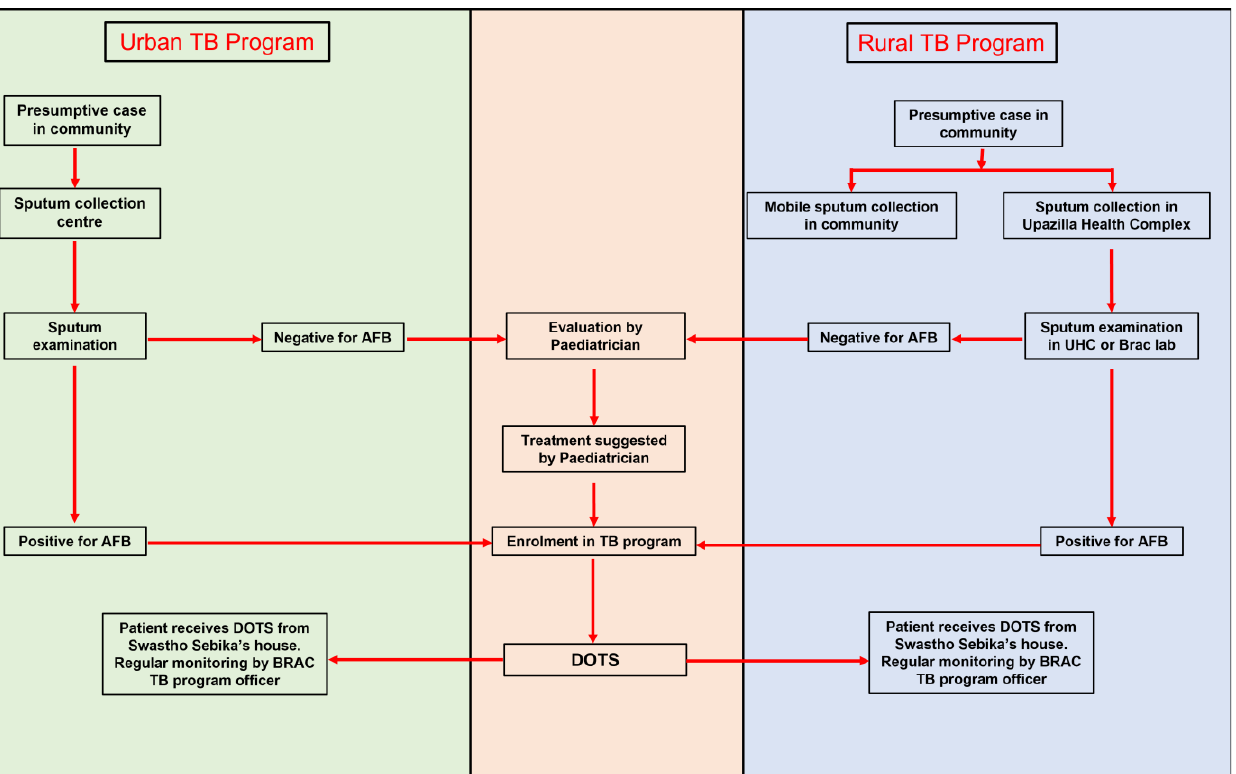
Figure 1. Implementation pathway of TB diagnosis and treatment in Bangladesh.